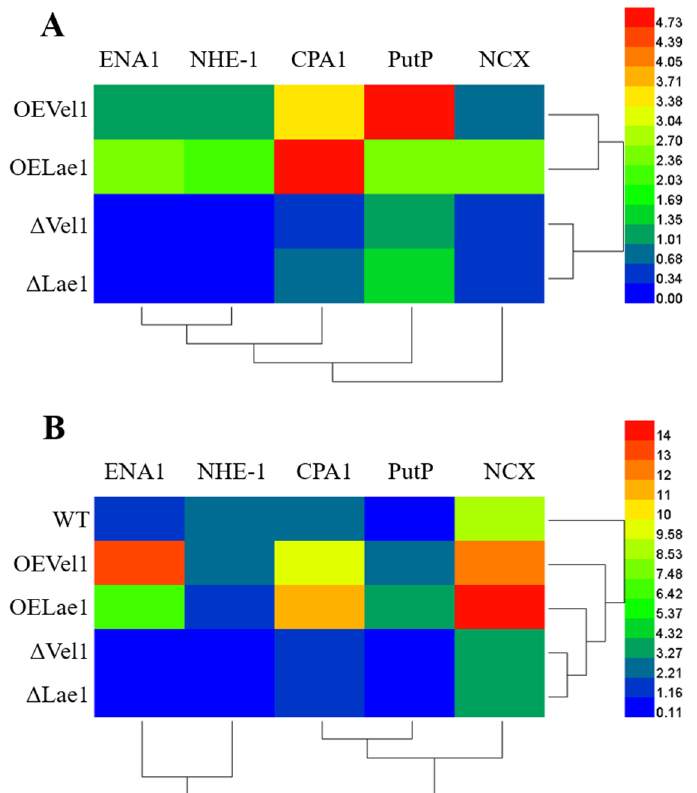
Figure 3. The regulation of putative Na + transporter genes involved in Na + homeostasis by the Vel1 and Lae1 genes under osmotic stress. The relative expression of putative Na + transporter genes under ( A ) normal and ( B ) saline conditions as its fold ratio with that of the WT grown under normal conditions. Results are the average of five replicates for each treatment; the values given are the standard error of the mean.